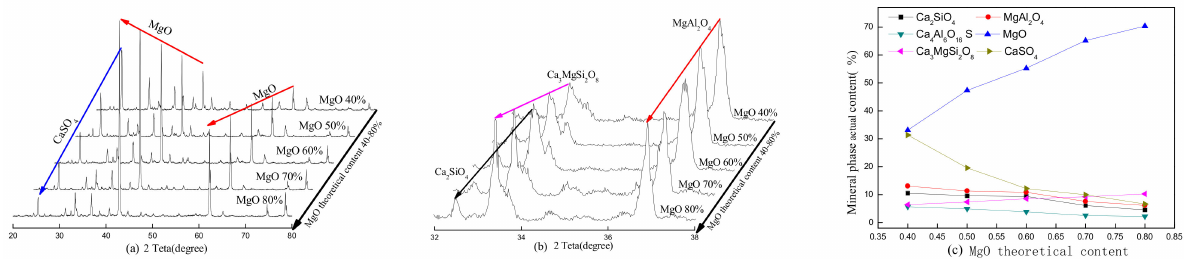
Figure 5. XRD patterns of the SAC-MKPC clinker with MgO theoretical content at 1250 ◦ C: ( a ) main phase; ( b ) minor phase; and ( c ) mineral phase actual content.